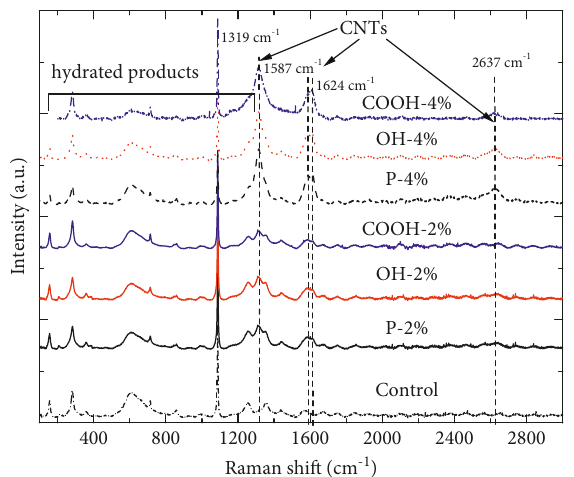
Figure 3: Raman spectra from the CNT-cement paste matrix. Contributions of the CNTs vibrational modes are above 1200cm − 1 . Raman spectra from ZnO, Gd 2 O 3, and SiO 2 matrices with